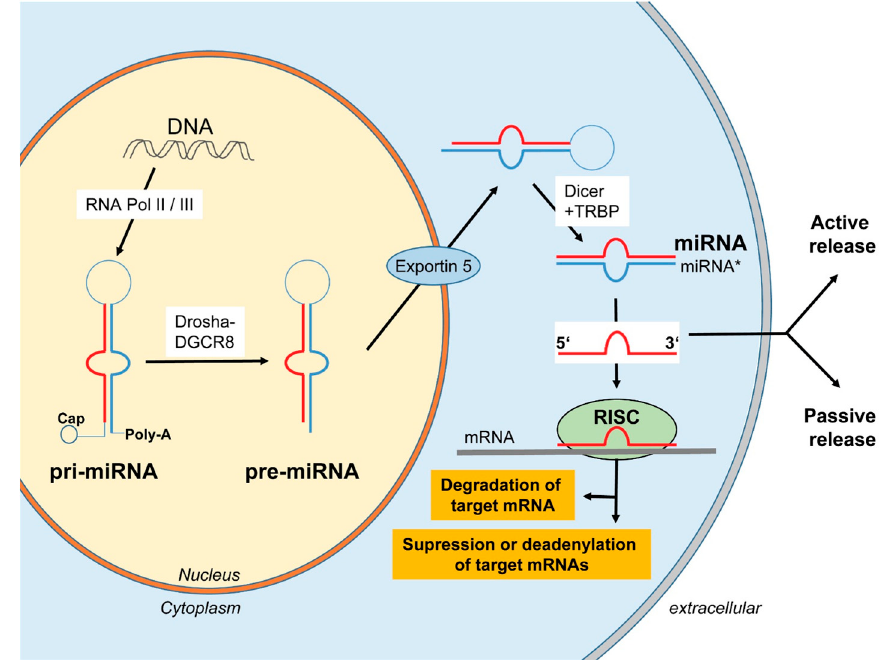
Figure 1. Biogenesis of miRNAs.